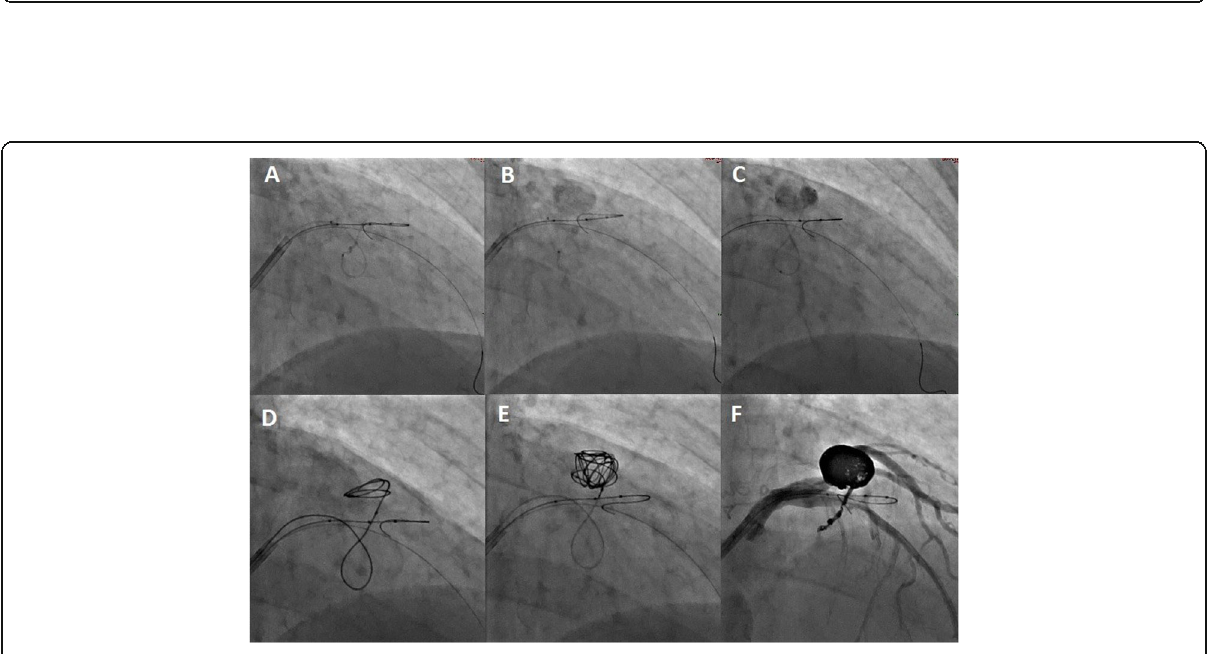
Fig. 4 a Superselective angiography via the Headway 21 microcatheter reveals a small septal feeder with flow into the large flow related aneurysm. b This was better characterised with inflation of the Scepter XC in the parent LAD occluding the dominant arterial feeder and reducing competitive flow c the microcatheter was advanced into the aneurysm sac and d - f multiple neurovascular coils of varying sizes were deployed to occlude the sac and inflow septal